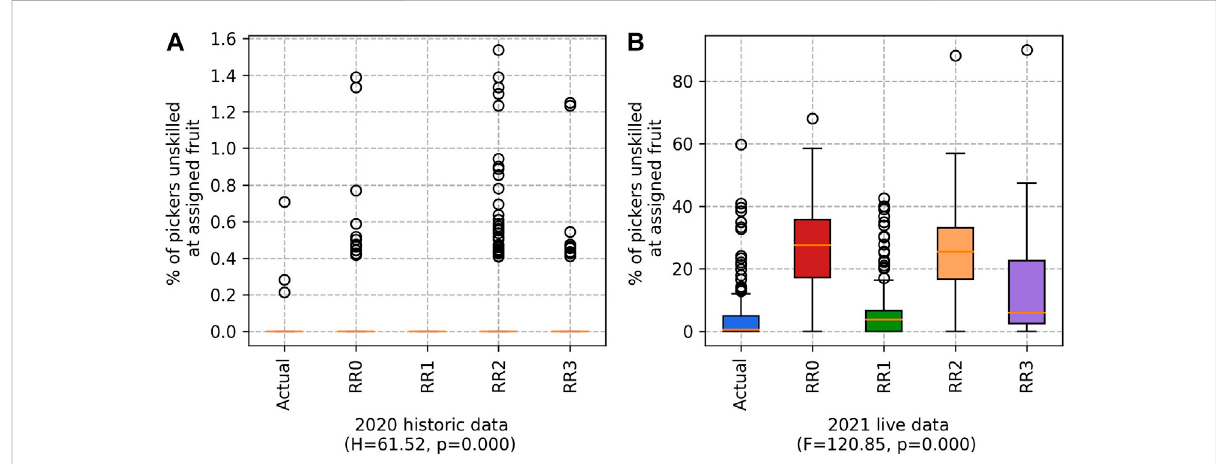
FIGURE 5 Percentage of pickers unskilled at assigned fruit for the (A) 2020 historic and (B) 2021 live datasets. (Lower values are better.)